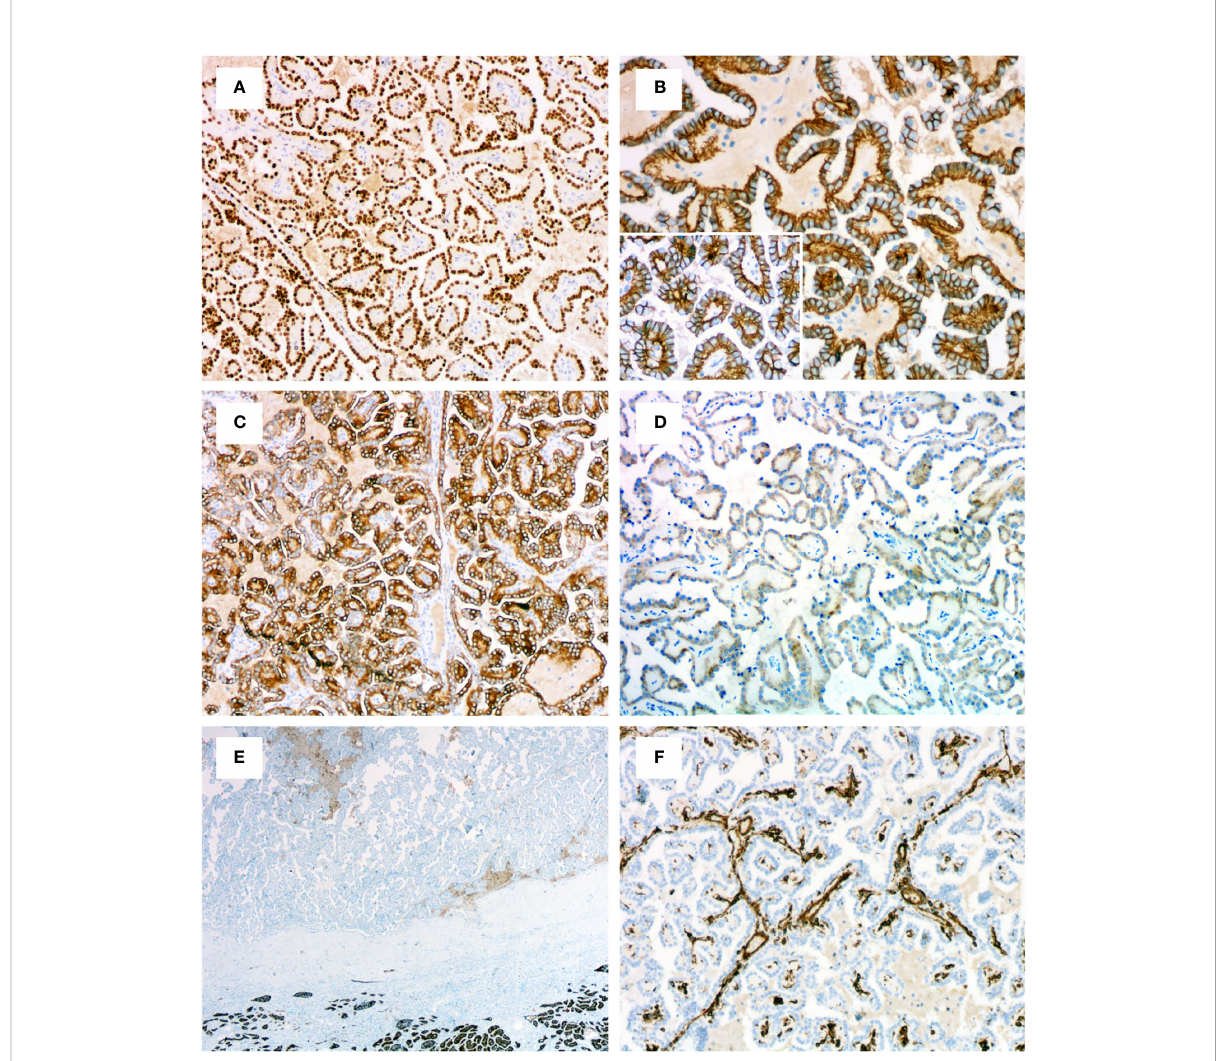
FIGURE 4 Immunohistochemical pro fi les of PRNRP. (A) Diffusely and strongly positive for GATA3 (medium magni fi cation). (B) Basolateral-membranous/ ” cup-like ” staining pattern of E-cadherin (high magni fi cation). (C) Positive for 34 b E12 (medium magni fi cation). (D) Weakly positive for AMACR (medium magni fi cation). Negative for CD10 ( E , low magni fi cation) and vimentin ( F , medium magni fi